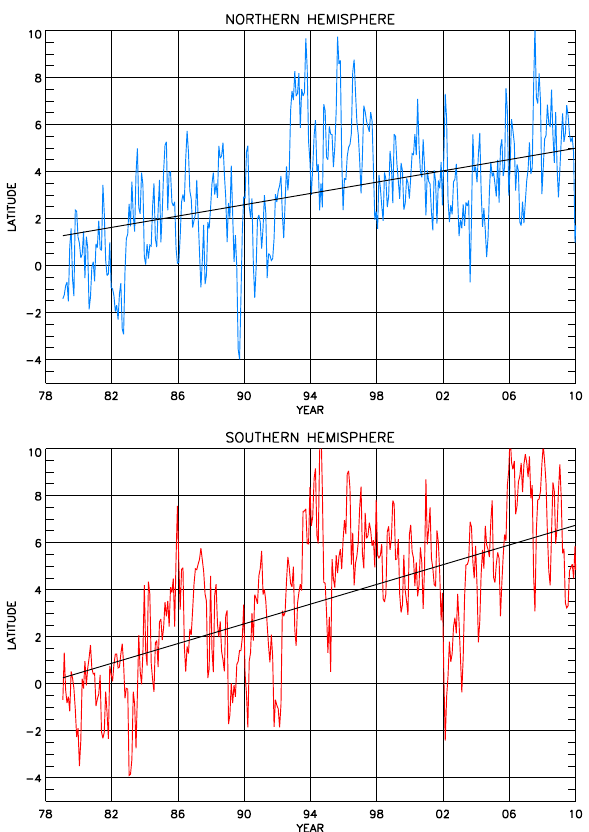
Fig. 9. Monthly mean equivalent latitude versus time for the sub- tropical front after the seasonal and QBO contributions have been removed. The solid black line shown for each hemisphere is the re- sult of a linear fit, including measurement errors, to the revised data.